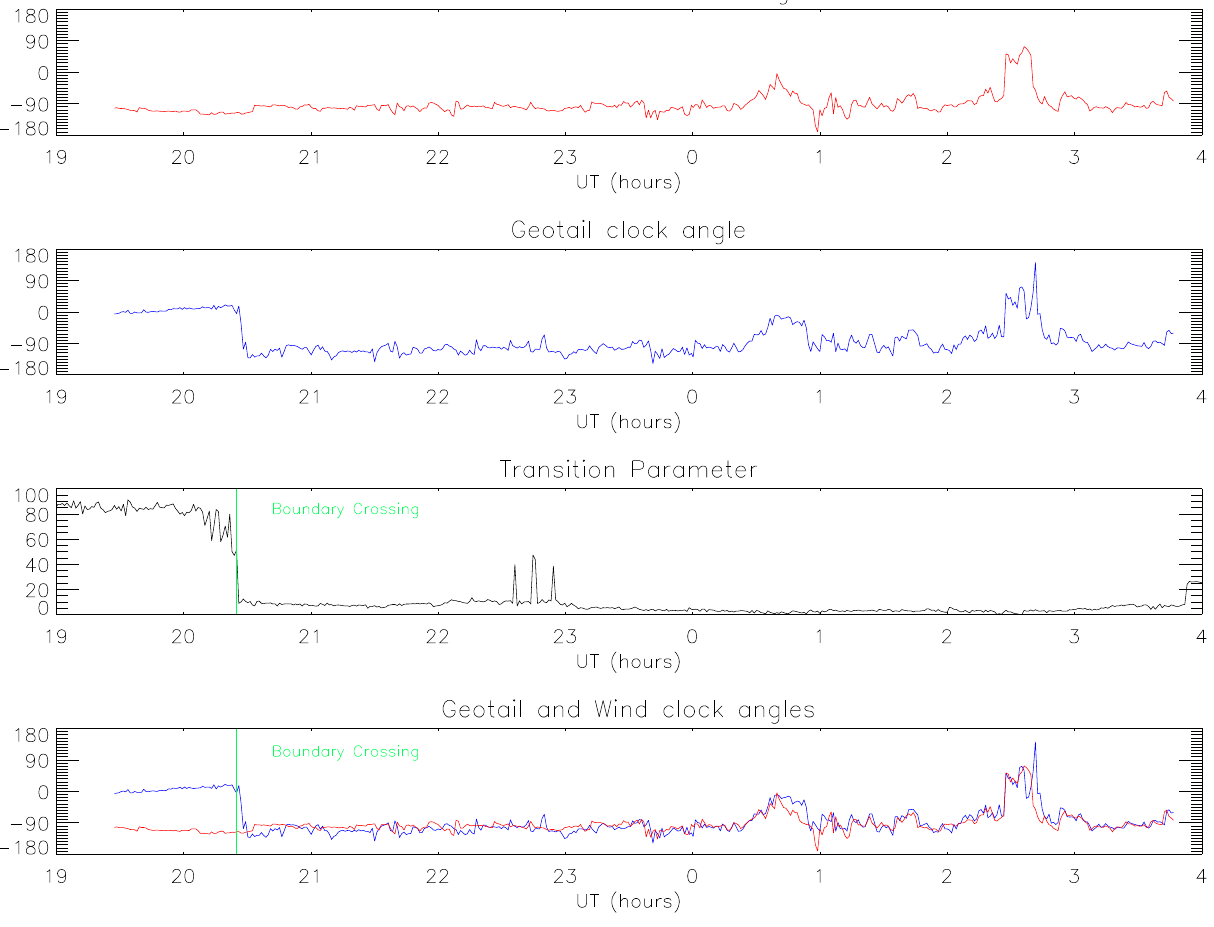
Fig. 1. An example of the magnetopause crossings used in this paper. The upper two panels show the magnetic field clock angles measured by the Wind and Geotail spacecraft; the Wind data have been timeshifted as described in Sect. 2.2. The third panel shows the transition parameter derived from the Geotail data (see Sect. 2.1) and the estimated time of the magnetopause crossing. In the bottom panel, the clock angle data from both spacecraft are overlaid, and the magnetopause crossing time indicated. This data set is from day 118,